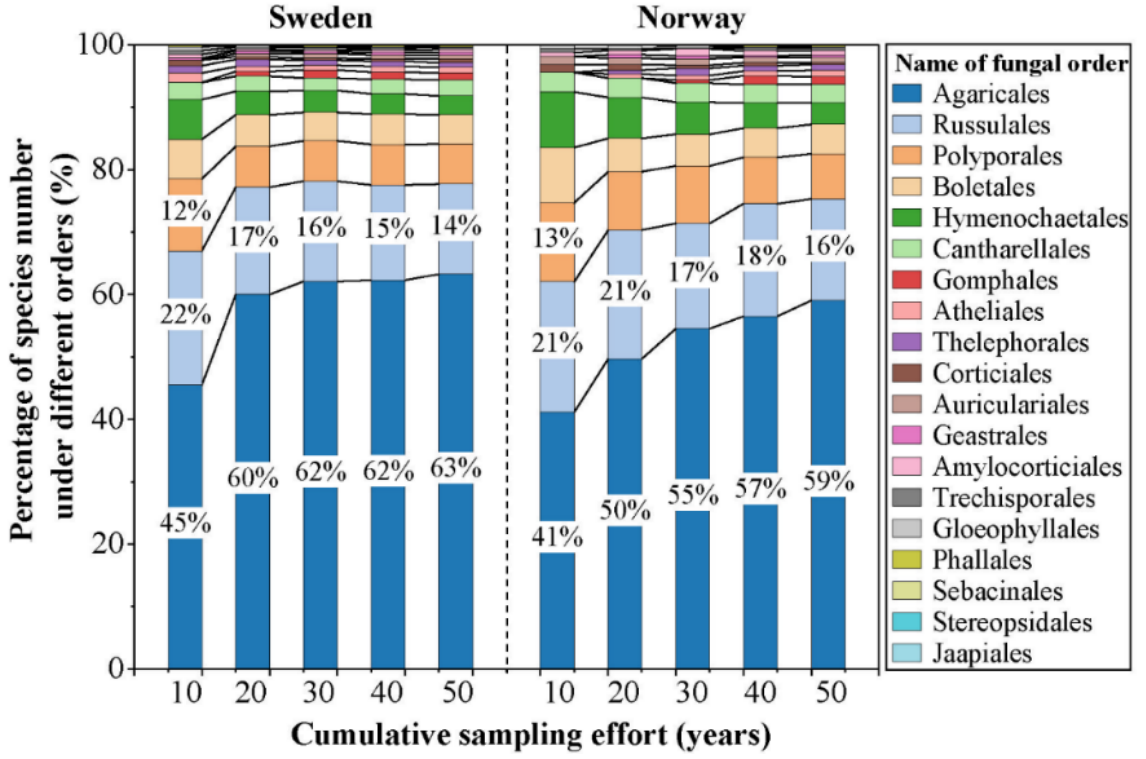
Figure 4. Percentage of species number under different orders in each accumulated sampling time